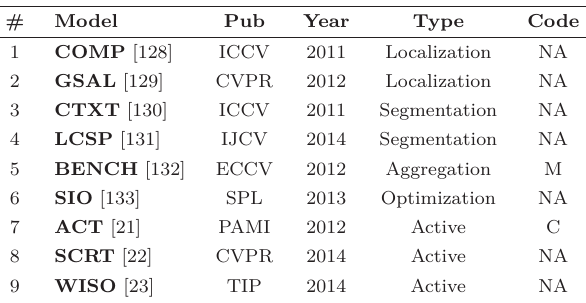
Table 3 Other salient object detection